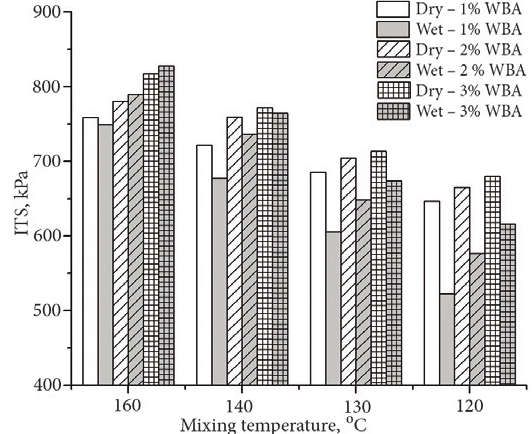
Figure 14. Dry and wet ITS values of WMA mixes